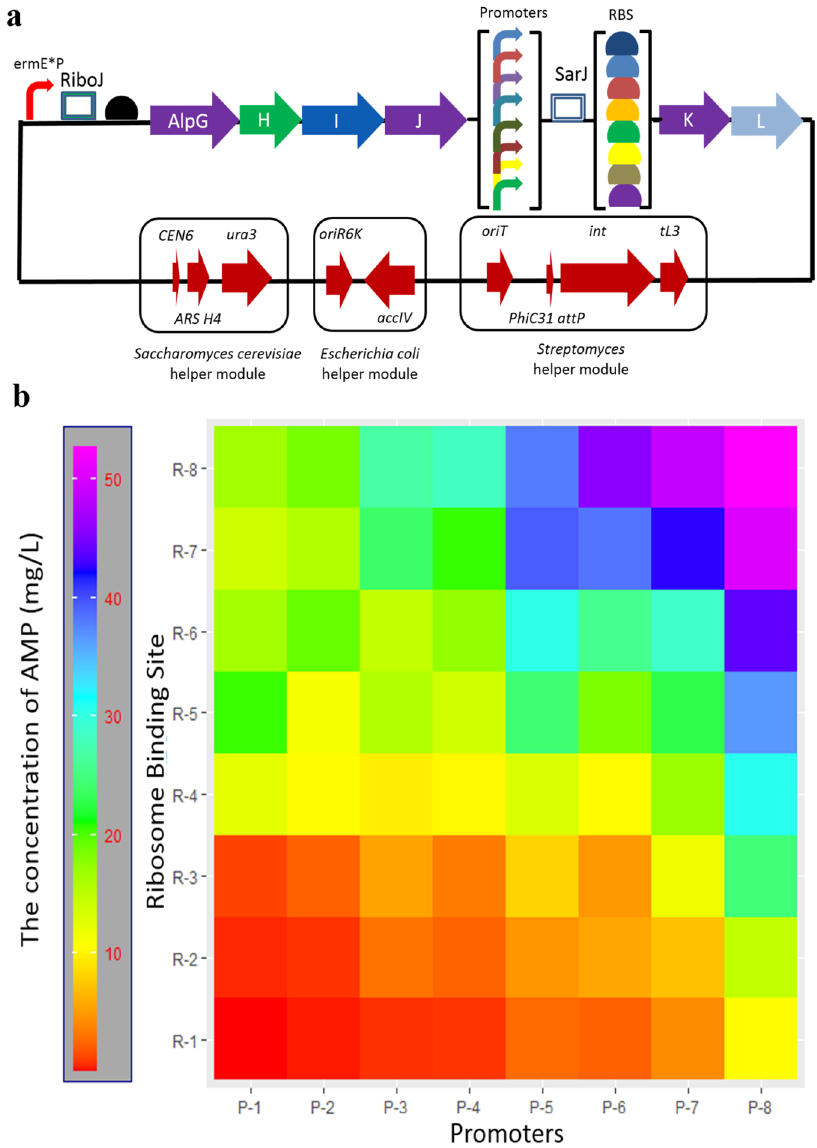
Fig. 7 Production improvement of AMP in S.lividans using a promoter-insulator-RBS strategy. a A scheme of the combined eight promoters and eight RBSs to form a full combinatorial library ofexpression control elements with the insulator RiboJ. b Heat maps show the production of AMP for all combinations of different promoters (P, columns) and RBSs (R, row). Each value was obtained bymeasuring AMP concentration with three experimental duplications. Source data are provided as a Source Data fi